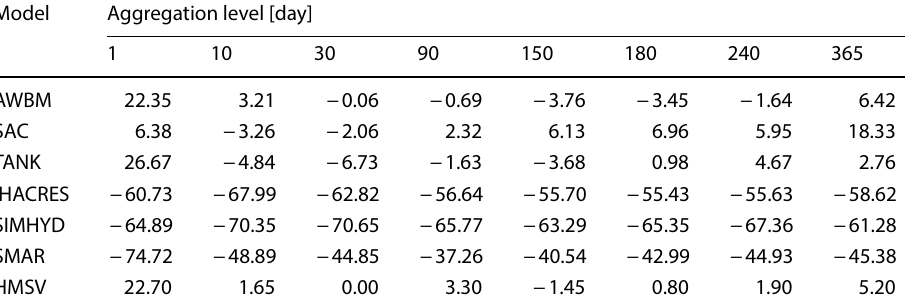
Table 5 Model biases (%) in simulating low-flow quantiles